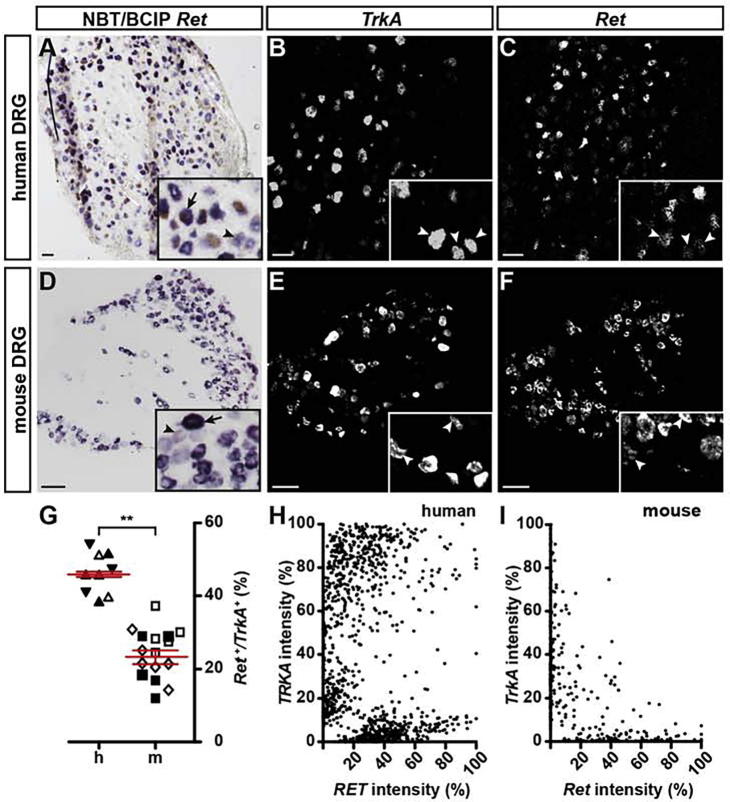
A neuron population expressing high levels of TRKA and medium to high levels of RET is present exclusively in human but not mouse DRGs. (A, D) Monochromatic images of single-color (NBT/BCIP) in situ hybridizations for Ret using human (A) and mouse (D) DRG tissue slices. Inserts show close-ups with arrows indicating neurons expressing high levels of Ret transcripts and arrowheads depicting neurons expressing low levels of Ret. (B, C, E, F) Monochromatic images of dual-color fluorescence in situ hybridizations for TrkA (B, E) and Ret (C, F) employing human (B, C) and mouse (E, F) DRG tissue sections. Inserts show magnifications of labeled neurons with arrowheads pointing to double-positive neurons. (G) Quantification of double-positive neurons (expressed as percentage of Ret positive cells of all TrkA positive cells) in human (h) versus mouse (m) DRG neurons, shows a significant difference in the amount of double-positive cells (linear mixed model, data shown as mean ± SEM; p = 0.002 **). Differently oriented or shaded triangles indicate percentages found in DRG sections obtained from different human individuals (N = 3), differently oriented or shaded squares depict percentages found in sections obtained from different mice (N = 3); (H, I) Analysis of the relative TrkA and Ret transcript expression levels (based on different fluorescent intensities) are shown for human (H) and mouse (I) DRG slices. Note the presence of a large group of RET/TRKA double-positive neurons in human DRGs (H) which is not detectable in mice DRGs (I). Scale bar = 100 μm. (For interpretation of the references to color in this figure legend, the reader is referred to the web version of this article.)